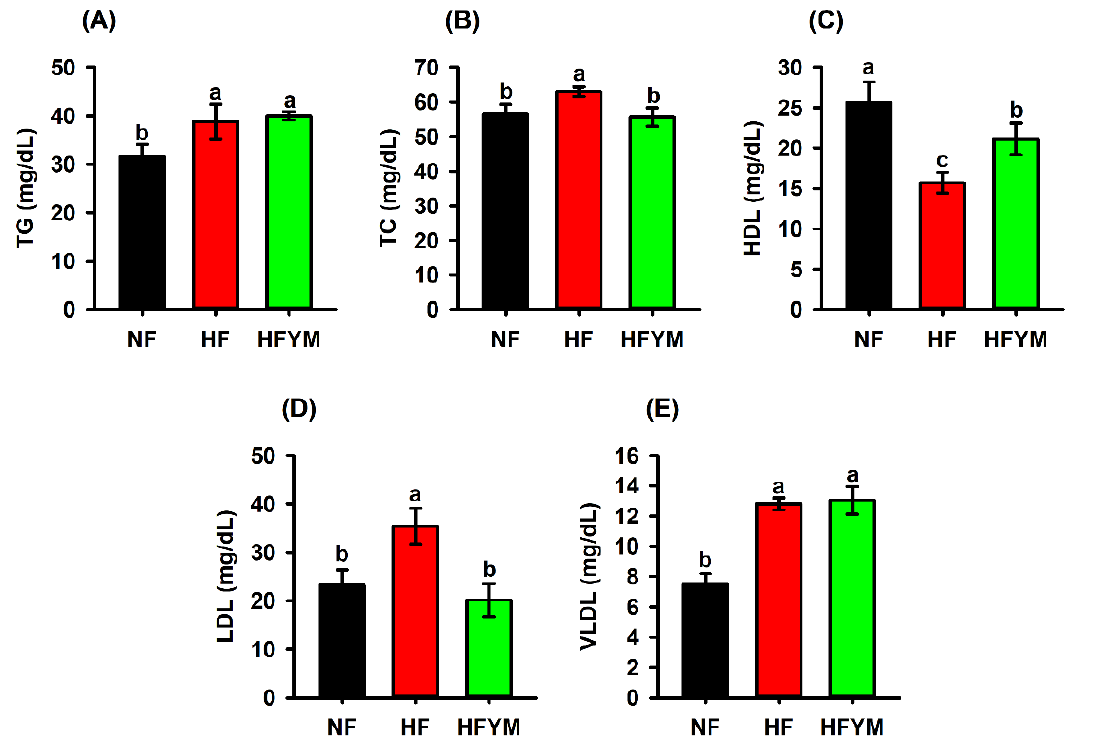
Figure 5. Triglycerides ( A ), total cholesterol (TC) ( B ), high-density lipoprotein HDL ( C ), low-density lipoprotein LDL ( D ) and very low-density lipoprotein VLDL ( E ) of rats fed a normal-fat or high-fat diet and supplemented or not with yellow mombin. TG = triglycerides; TC = total cholesterol; HDL = high-density lipoprotein; LDL = low-density lipoprotein; VLDL = very low-density lipopro- tein; NF = normal-fat diet; HF = high-fat diet group; HFYM = high-fat diet group supplemented with yellow mombin. Data are represented with mean ± standard deviation. (a, b, c) Different lowercase letters in the bars indicate that there was a statistical difference among the groups (one way ANOVA followed by Tukey’s post-test, p ≤ 0 .05).